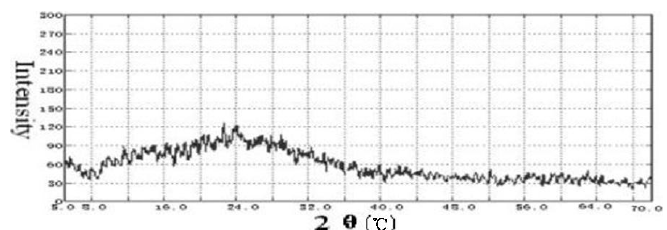
Figure 6. The XRD result of solution casting films of